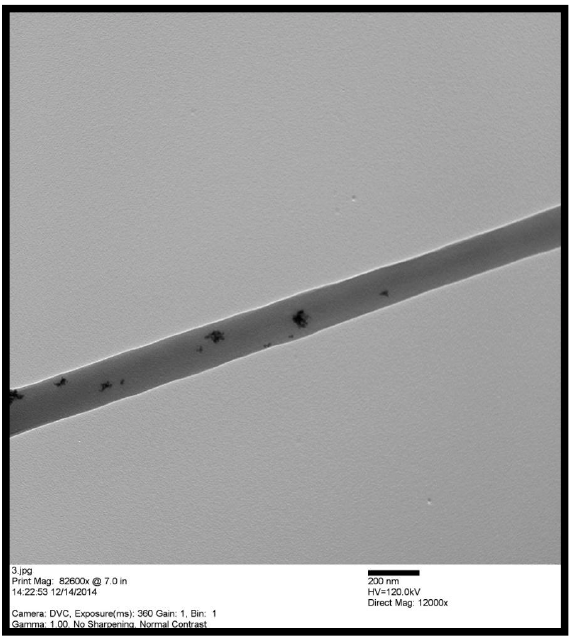
Figure 4. Transmission electron microscope (TEM) image of Pd/PVDF-HFP nanofibers.